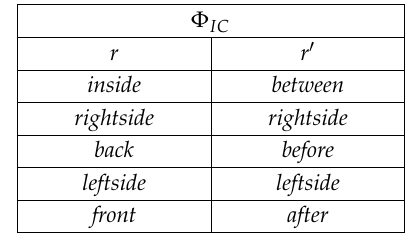
Figure 5. In this frame of reference, the directional relations inside, rightside, back, leftside, and front are identified. They can be mapped to 5-intersection relations by the following transformation function for the intrinsic-geometric (IC) frame of reference Φ IC :